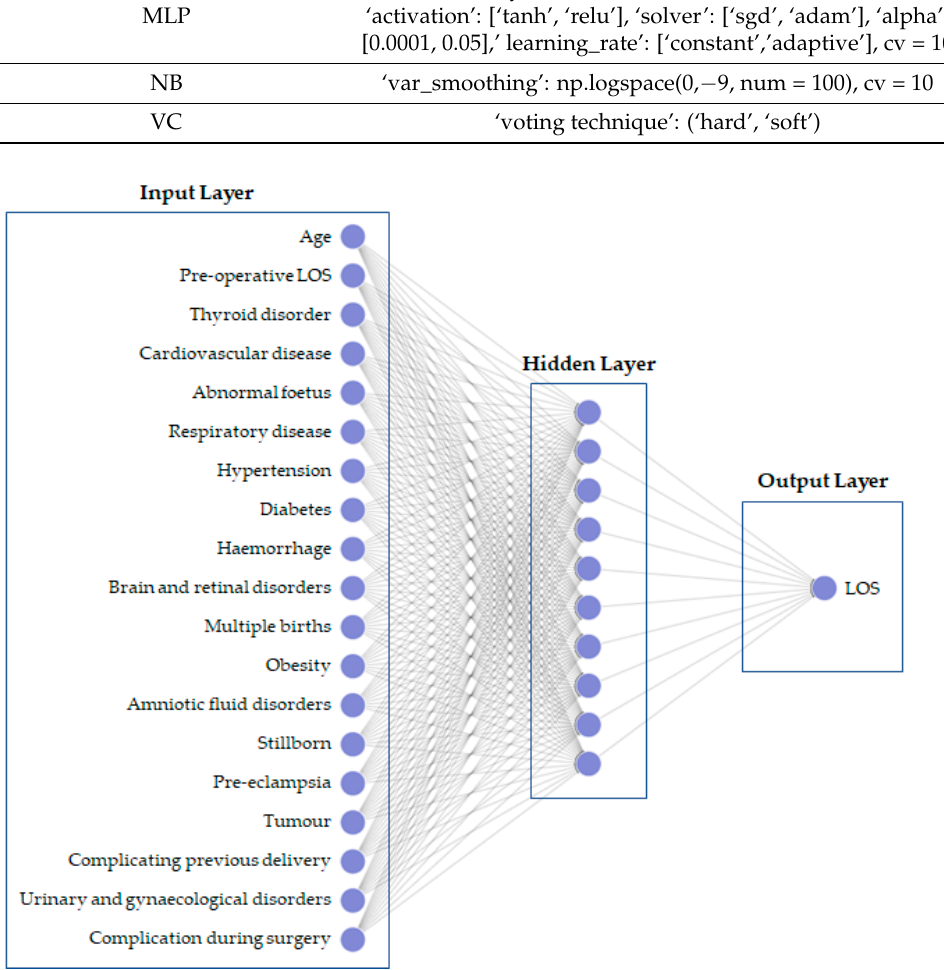
Figure 2. Artificial neural network architecture.